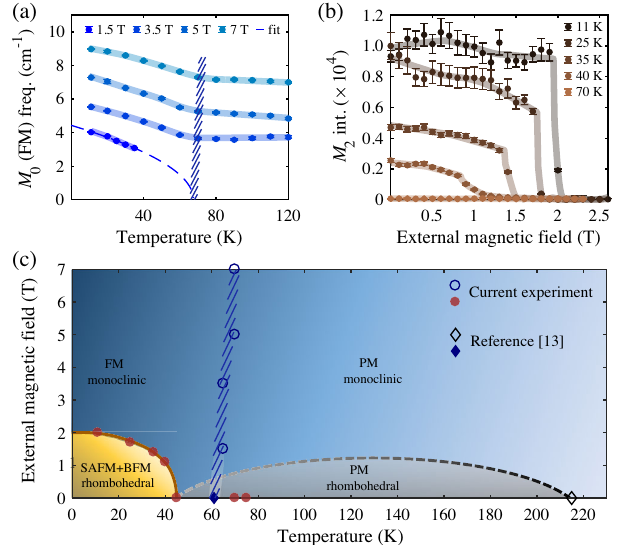
FIG. 4. Constructing the temperature vs external magnetic field phase diagram for 3D CrI 3 . (a) Temperature dependence of the M 0 frequency for the FM spin-wave branch at multiple magnetic c fields of 1.5 T (below B ), 3.5, 5, and 7 T (above B ). The dashed c c line is a fit to the data taken at 1.5 T, while the solid lines are guide to the eyes. The striped pattern highlights the crossover between the paramagnetism (PM) and ferromagnetism (FM). (b) Magnetic field dependence of the M 2 intensity at multiple temperatures of 11, 25, 35, 40 K (below T ), and 70 K (above T ). Error bars c c correspond to one standard error of the fitted parameters. (c) A temperature vs external magnetic phase diagram constructed based on both the findings from the current work (blue open and brown filled circles) and the literature (blue open and filled diamonds, Ref. [13]). The brown solid line represents a true phase boundary between the mixed magnetic phase with a rhombohe- dral structure and the FM phase with a monoclinic structure. The gray dashed line is for a potential phase boundary between the rhombohedral and monoclinic PM phases. The blue stripped pattern indicates the crossover between the PM and FM